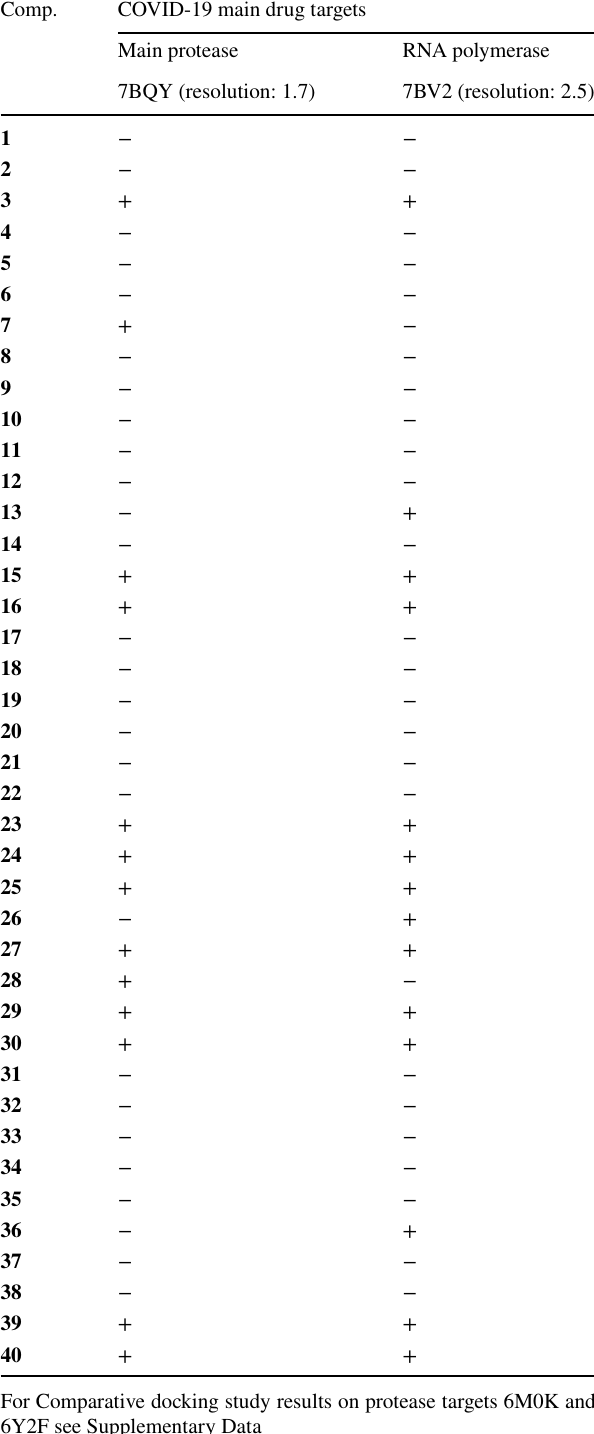
Table 1 Comparative docking study results on COVID-19 enzymes